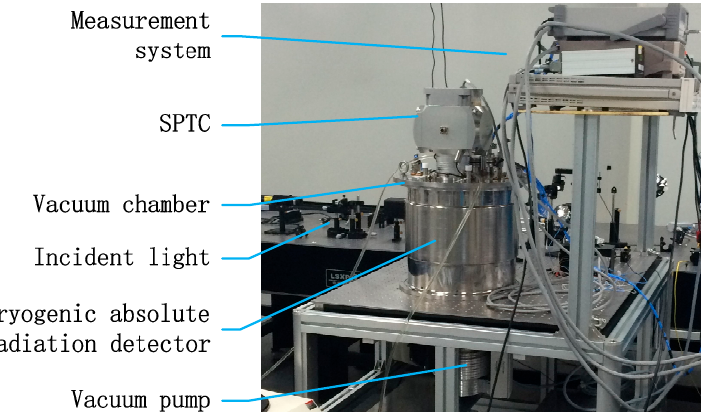
Figure 5. The Space Cryogenic Absolute Radiometer (SCAR) prototype. SPTC: Stryn-type Pulse Tube Cryocooler.